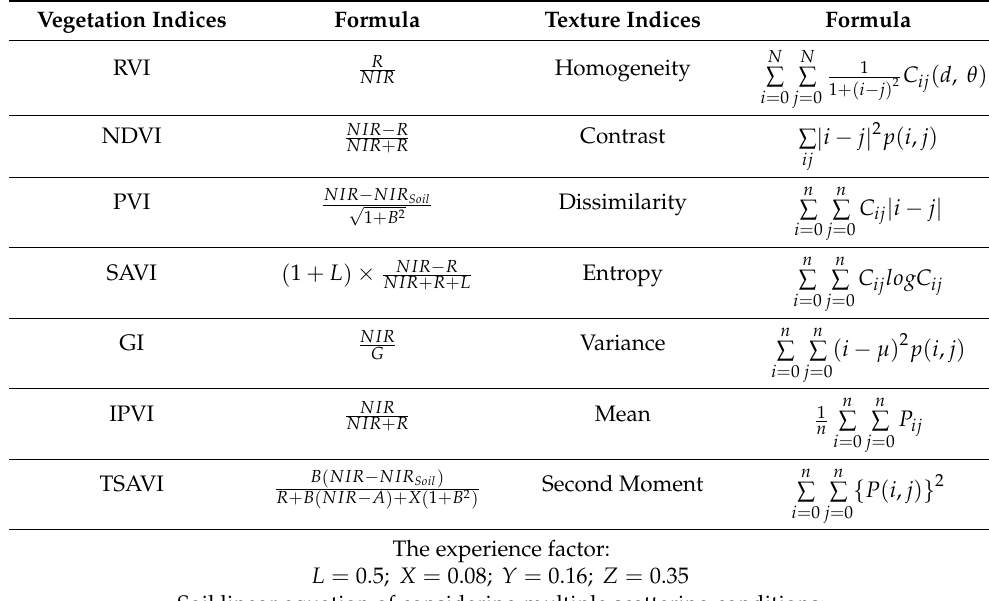
Table 1. Formula list of vegetation indices and texture information.